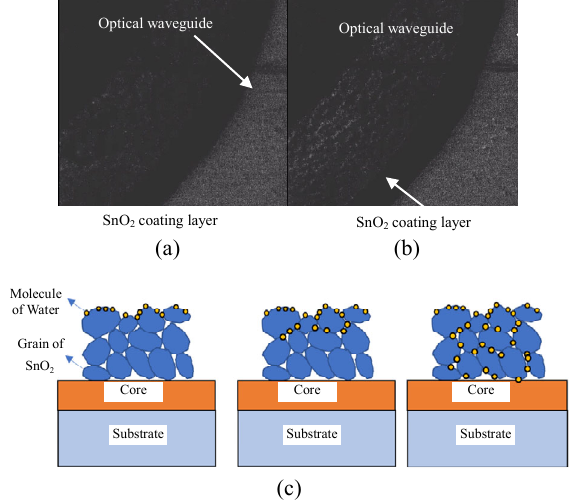
Fig. 9 Absorption phenomenon in different conditions of humidity: (a) before humid air was introduced in the ambient environment, (b) when humid air from exhaling was introduced, and (c) schematic of water absorptions at low humidity, intermediate humidity, and large